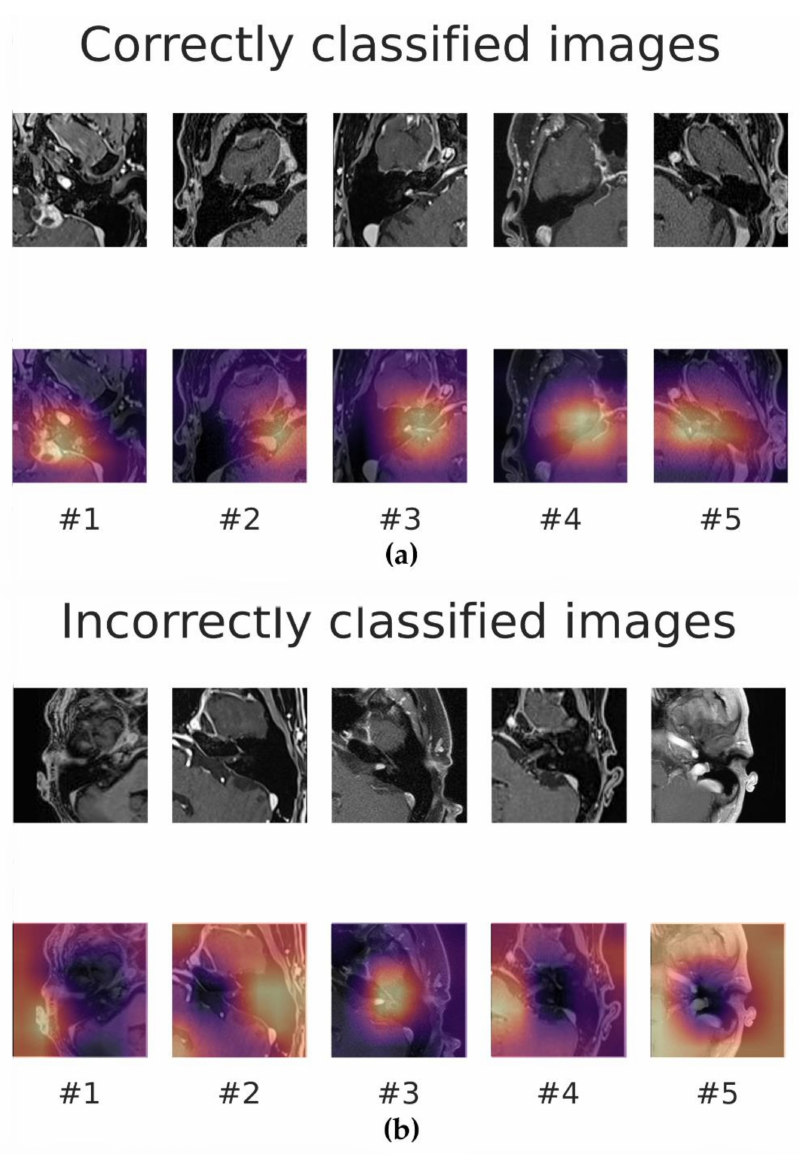
Figure 7. Sample MRI slices of the T1c data set with and without gradient-weighted class acti- vation mapping (Grad-CAM). ( a ) The correctly classified images are shown above; ( b ) the incor- rectly classified slices are shown below. Bright yellow and purple correspond with high and low activation,